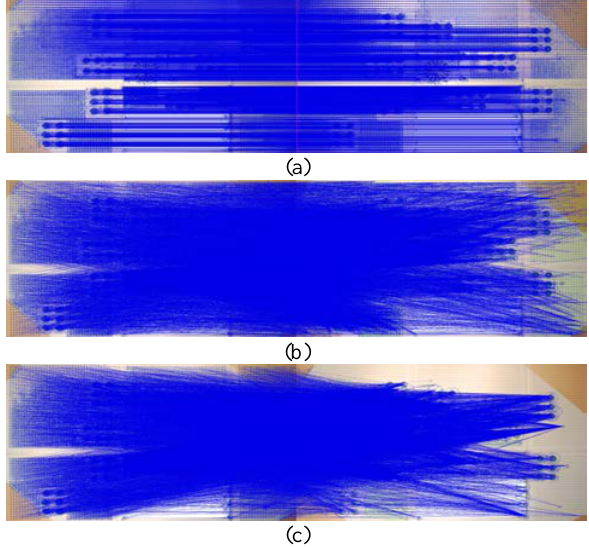
Figure 2. Influence of image blur on automatic feature detection and connection using SURF and brute force matching. Left image is a sharp reference image. Blue lines and circles indicate feature points (a) Right image without camera displacement. (b) Right image with 0.377 mm camera displacement. (c) Right image with 1.028 mm camera